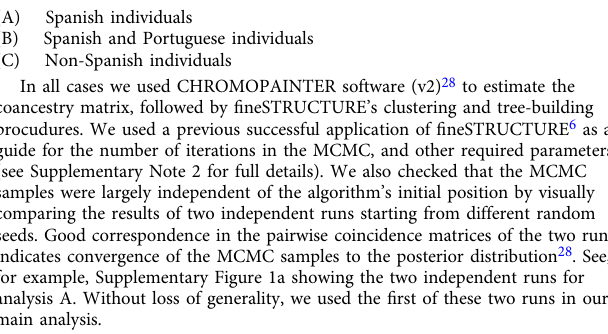
Affymetrix 6.0 array. We fi rst merged these data and then applied quality fi lters to the combined dataset of 6617 individuals, which we then phased altogether. After excluding related individuals, those with self-reported mixed ancestry, and sub- sampling some heavily sampled regions (e.g. Switzerland) the dataset comprised 2919 individuals and 300,895 SNPs, which we used in our joint analyses. See Supplementary Note 1.2 for full details of quality control and phasing.